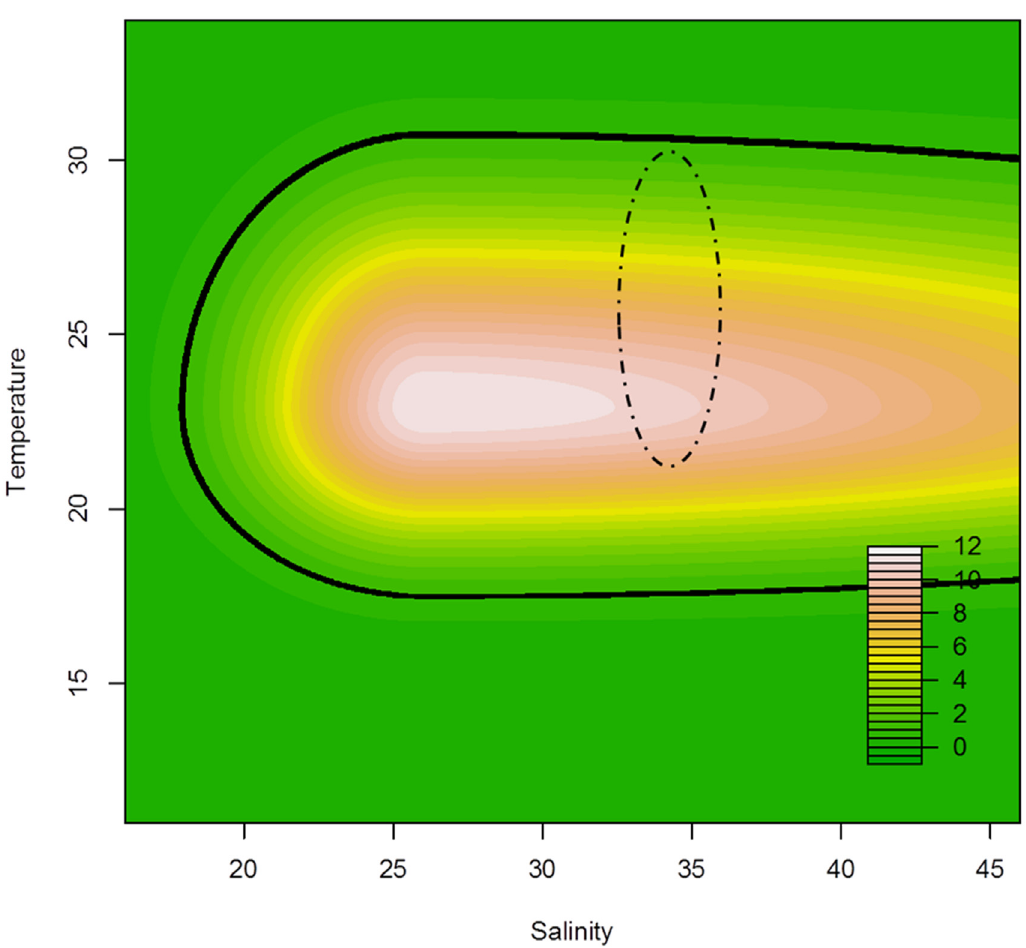
Fig 1. Maximum likelihood estimated proportional change in polyp density after six weeks plotted as a function of temperature and salinity from best-fit model. Model output describes proportional change in polyp density for different temperature and salinity values as described in Eq 1. Solid black line represents values of 1, where polyp density is expected to remain constant. The area encompassed by the dashed line indicates sea surface temperature and salinity levels that commonly occur within the waters of the Great Barrier Reef [44,45]. Models were fit to data collected from a matrix of eight temperature and ten salinity treatments, each replicated six times. Summary statistics describing the data used to generate the model are provided in Supporting Information (S1